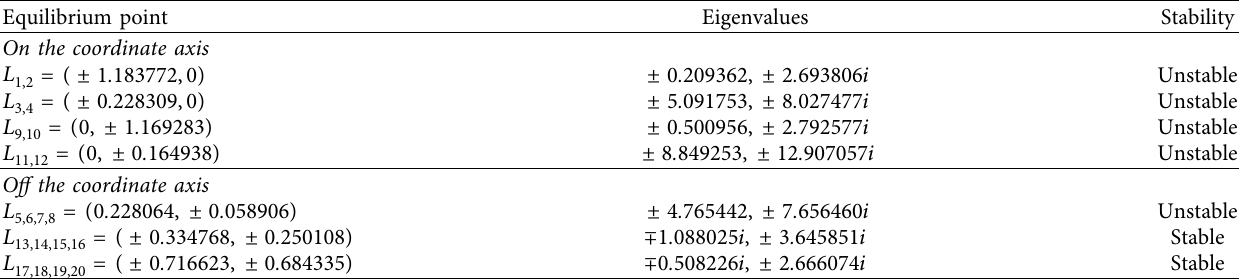
Table 2: Equilibrium points, eigenvalues, and stability status when b � 0 . 60 and a � 0 . 68 .